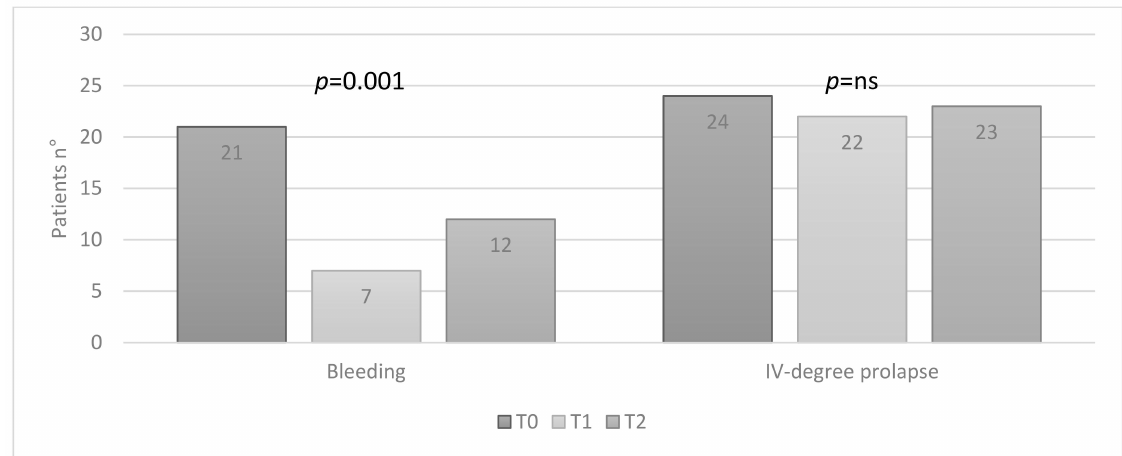
Figure 4. Group B: patients with bleeding and IV-degree hemorrhoidal prolapse, at T0, T1 and T2 (Friedman test).